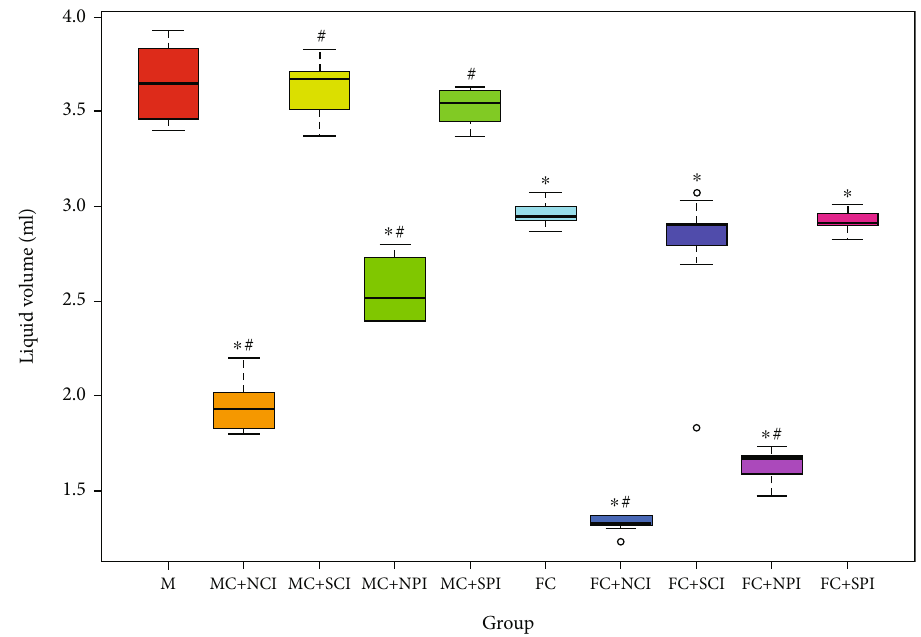
Figure 5: Comparison of distension volume threshold to reach AWR score = 3 among groups after NUCB2/Nesfatin-1 intervention. N = 8 per group. ∗ P < 0 : 05 , compared with the MC group; # P < 0 : 05 , compared with the FC group. MC group: male model control group; MC +NCI group: NUCB2/Nesfatin-1 central intervention group; MC+SCI group: central intervention control group; MC+NPI group: